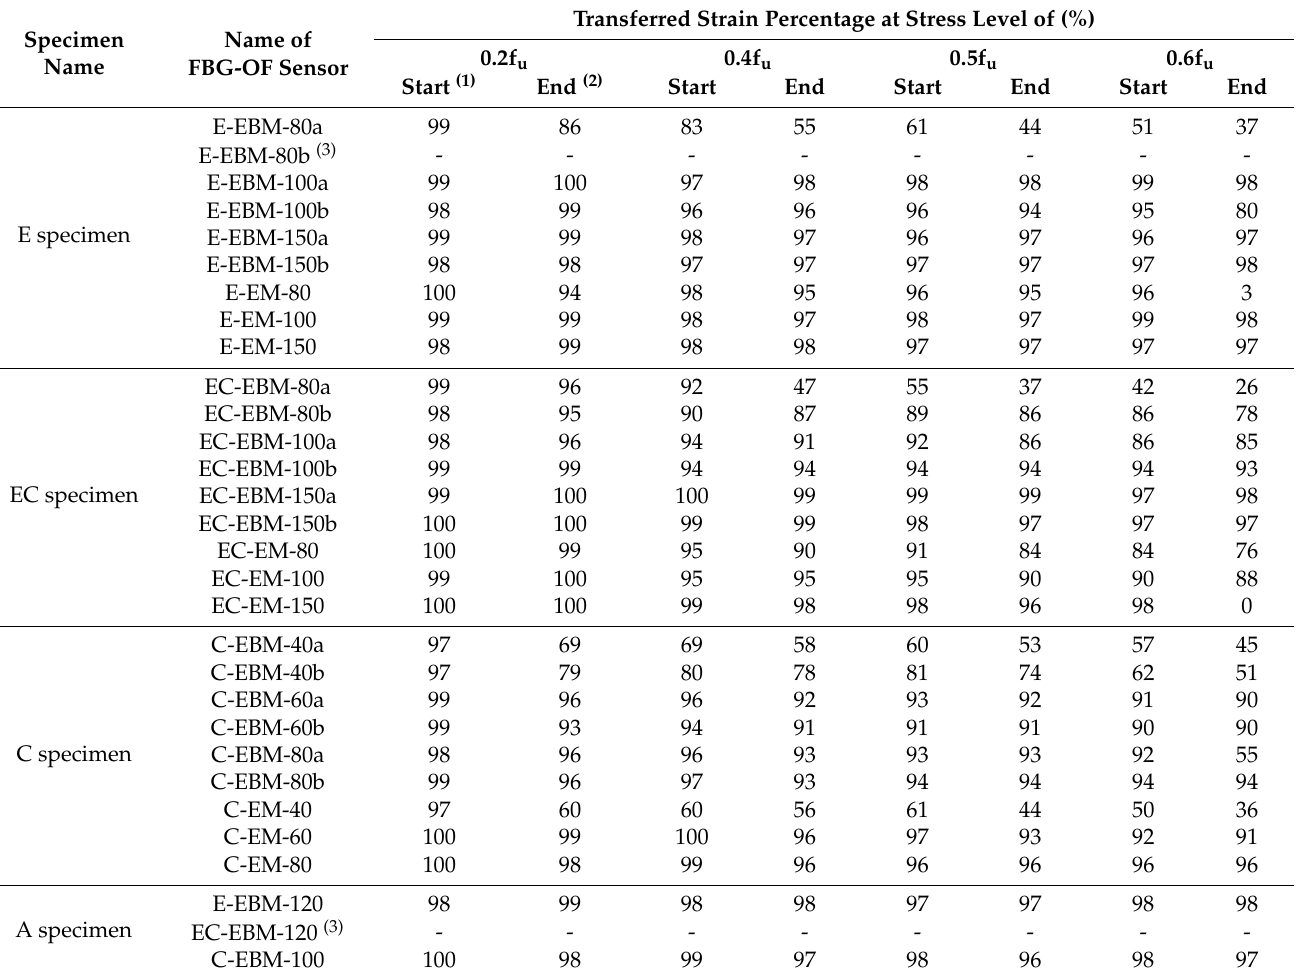
Table 5. Transferred strain percentages from the FRP strip to the FBG-optical fiber